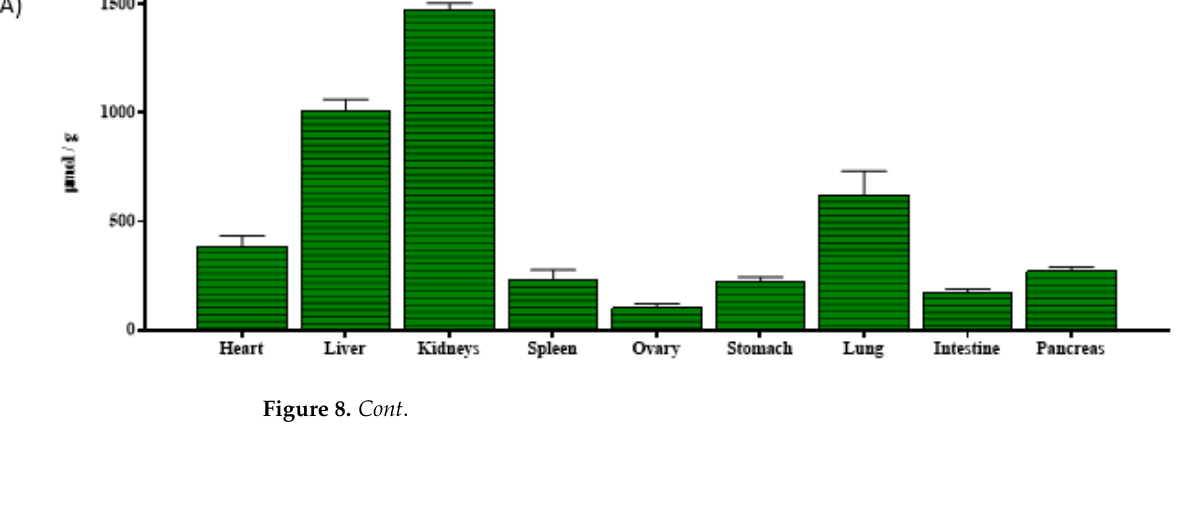
Figure 8. ( A ) Iridium biodistribution in extracted organs 4 h after i.v. injection of 1[C,NH] . ( B ) In vivo monitoring scheme. ( C ) Luciferase activity quantification measured in protein extracts of lung or mediastinal nodes. ( D ) Immunohistochemical staining of mouse lungs using anti-CK7 antibody. Left: control group. Right: Treated group. Brown stain shows tumor cells. 4. Conclusions A family of eight arylbenzazole-based iridium(III) complexes have been rationally designed, prepared and characterized, in order to set a SAR study. Substitutions on the atoms of the ancillary ligand led to changes in the global charge of the complex, modulat- ing their solubility and considerably affecting their biological properties. The SAR study revealed that complexes with N^N neutral chelating ligands are wa- ter soluble and form aqua complexes. However, the neutral complexes bearing anionic C^N and O^N ligands are soluble in DMSO and not in water, leading to the replacement of the chloride leaving group by DMSO. Regarding the cytotoxic activity, all the com- plexes showed activity in the complexes bearing the anionic ligands C^N and O^N are more cytotoxic than those with N^N ligands. In addition, the NH moiety of the imidazole seems to play an important role in the cytotoxicity when compared with the N-methylated